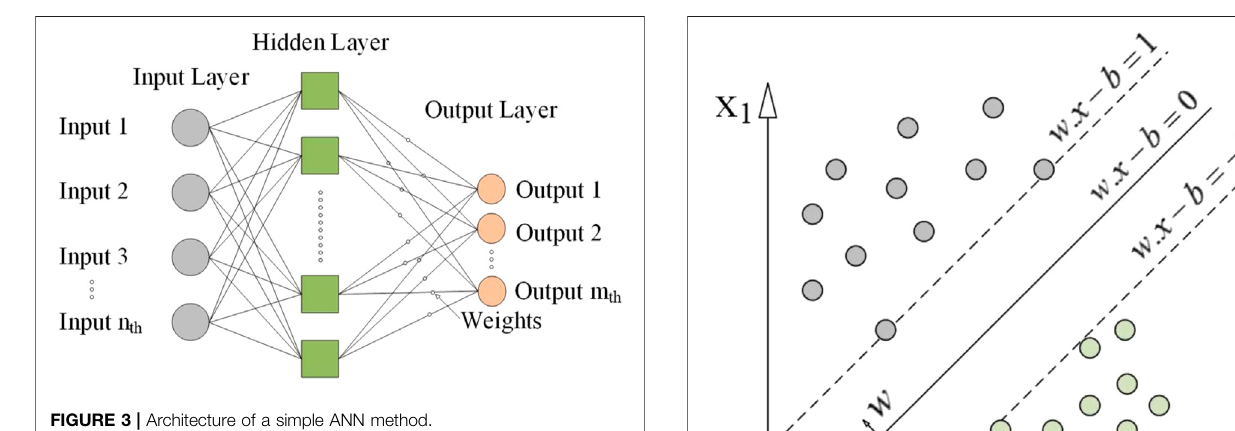
FIGURE 3 | Architecture of a simple ANN method.